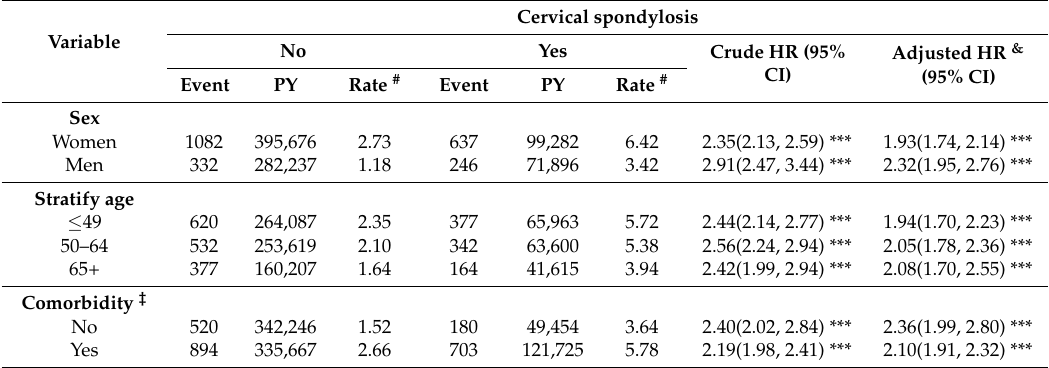
Table 3. Comparison of incidence rate of migraine hazard ratios (HR) between individuals with and without CS based on demographic characteristics and comorbidities.